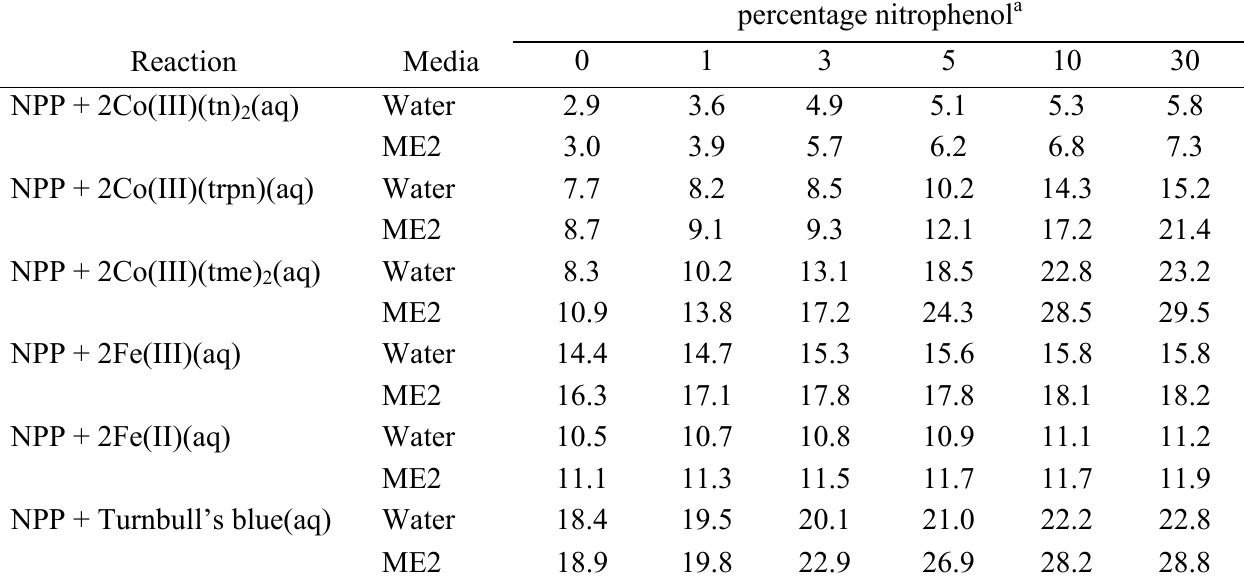
, 25 o C, pH 6.5) 4